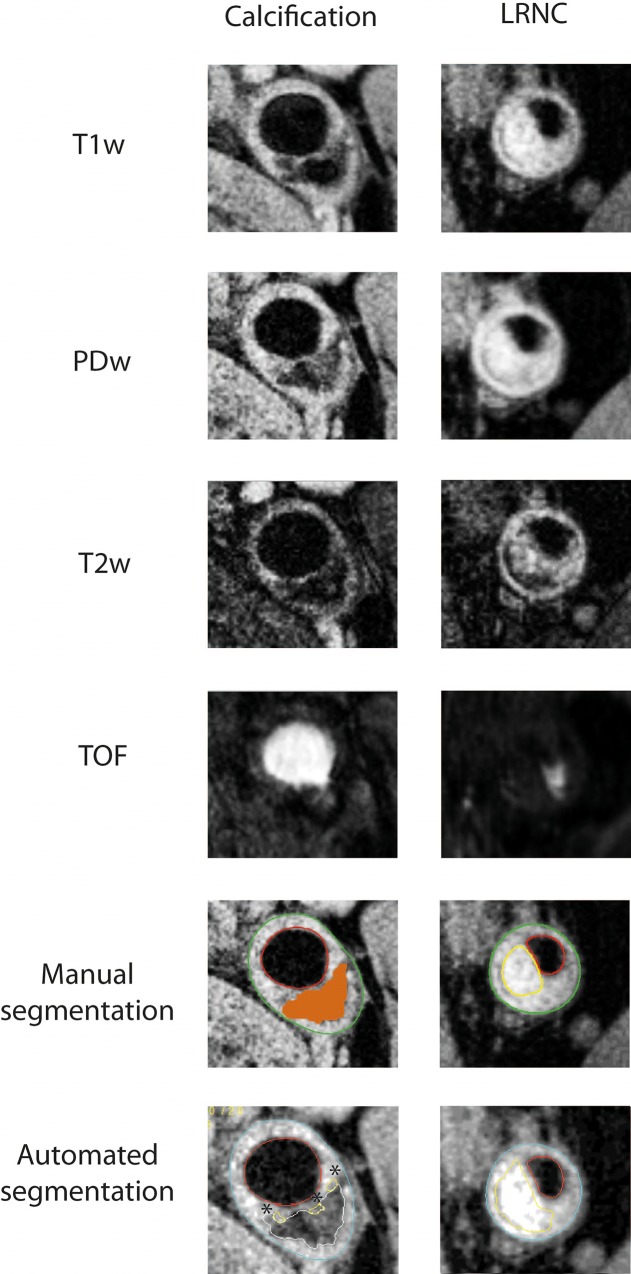
Representative images of manual and automated segmentation of LRNC and calcifications.Representative images of the manual and automated segmentation of a calcified plaque area and a lipid-rich necrotic core (LRNC) using a multicontrast MRI protocol of the carotid artery. Shown are all the individual MRI sequences (T1w,PDw,T2w,TOF), as well as the manual and automated analysis. Lumen contours were delineated in red for both methods, and outer wall contours were delineated in green for manual segmentation, and light blue for automated segmentation. Calcified plaque areas were coloured orange in manual segmentation, and delineated white in automated segmentation. LRNCs were delineated yellow in both manual and automated segmentation. In these examples, both methods agree on the identification of a large calcified plaque area (left example) and large LRNC (right example). Please also note the identification of three small LRNC areas using automated segmentation (*), which are not detected by manual segmentation.